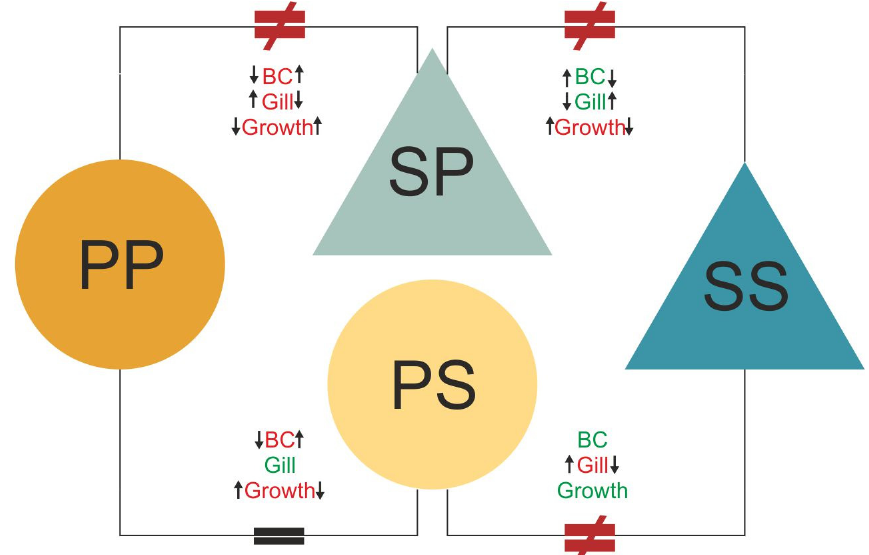
Figure 5. Schematic representation of physiological and transcriptomic results in response to habitat alteration. Circles and triangles represent treatment groups: P-P: Non-transferred pond individuals; P-S: Pond individuals transferred to streams; S-P: Stream individuals transferred to ponds; S-S: Non-transferred stream individuals. Text between treatment groups represents physiological results: BC: Body condition index; Gill: Gill length; Growth: Growth rate; and the arrows represent direction of the differences between groups. Connections between treatments represent similarity (=) and dissimilarity ( ≠ ) observed in transcriptomic responses.